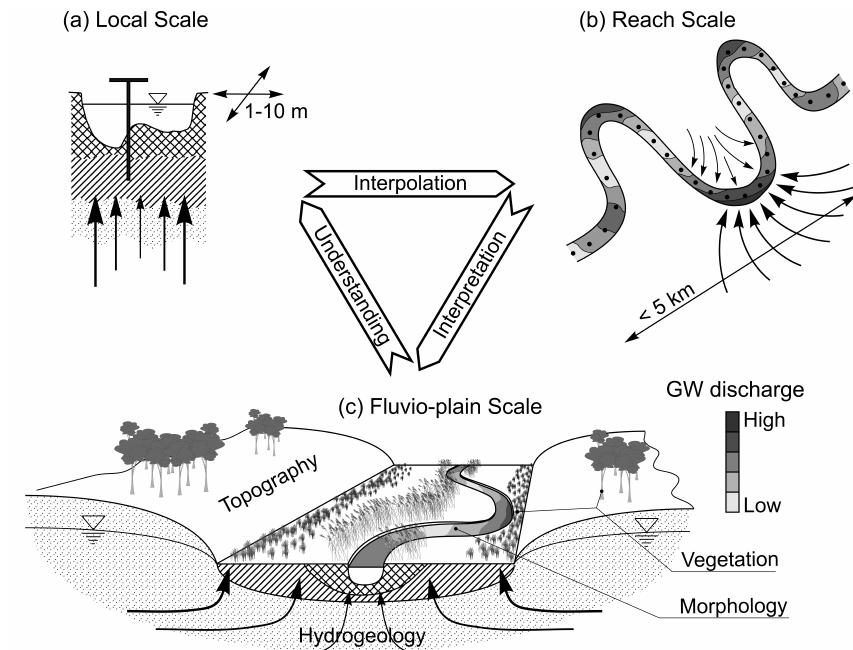
Fig. 6. Concept for the estimation and understanding of groundwater-surface water interaction. (a) Field measurements represent point esti- mates on a local scale: bathymetry, composition of the riverbed and the measurement position influence of the vertical flux estimate (e.g. local factors). (b) Interpolation reveals spatially distributed exchange patterns on a reach scale indicated in grey scales. For example, converging and diverging flow lines cause different exchange fluxes at convex and concave sides of meanders, respectively. (c) The quantity of exchange fluxes is dependent on morphology, topography, climate, vegetation and hydrogeology (e.g. regional factors). Hence, the interpretation of the groundwater-surface water interaction system is only possible when the system is analyzed at sub-basin or fluvio-plain scale. The im- proved understanding of the hydrological system is used to update, improve and control future investigation and modeling efforts on the local scale (a)